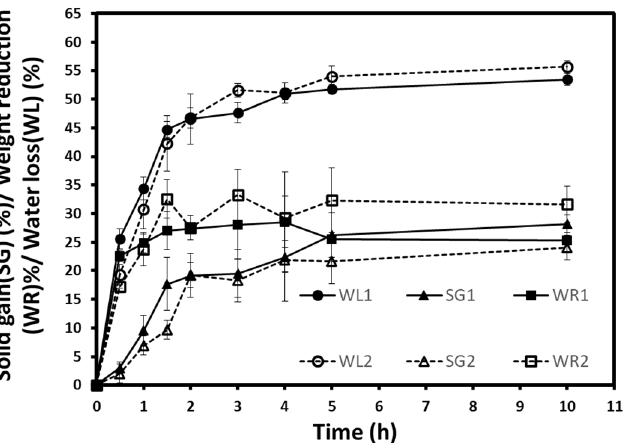
Figure 2. Water loss, solid gain, and weight reduction of autumn berries during osmotic dehydration at atmospheric pressure (1) and vacuum pressure (2). Each point represents the mean and standard deviation of a duplicate of three repetitions.